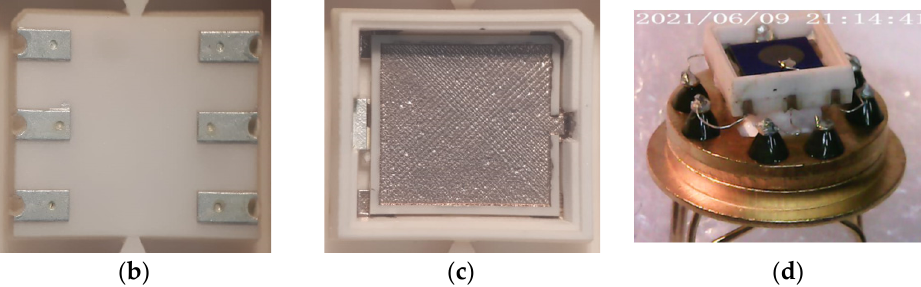
Figure 4. Assembling the sensor into the miniature metal–ceramic package: ( a ) bottom part of package with silver metallization—top view; ( b ) bottom part of package with silver metallization—top view; ( c ) assembling heater with bottom part of package by soldering; ( d ) final image of the field-effect gas sensor based on a Si chip assembled in the metal–ceramic package glued into a TO-8 package holder for tomography and gas-sensitive tests.